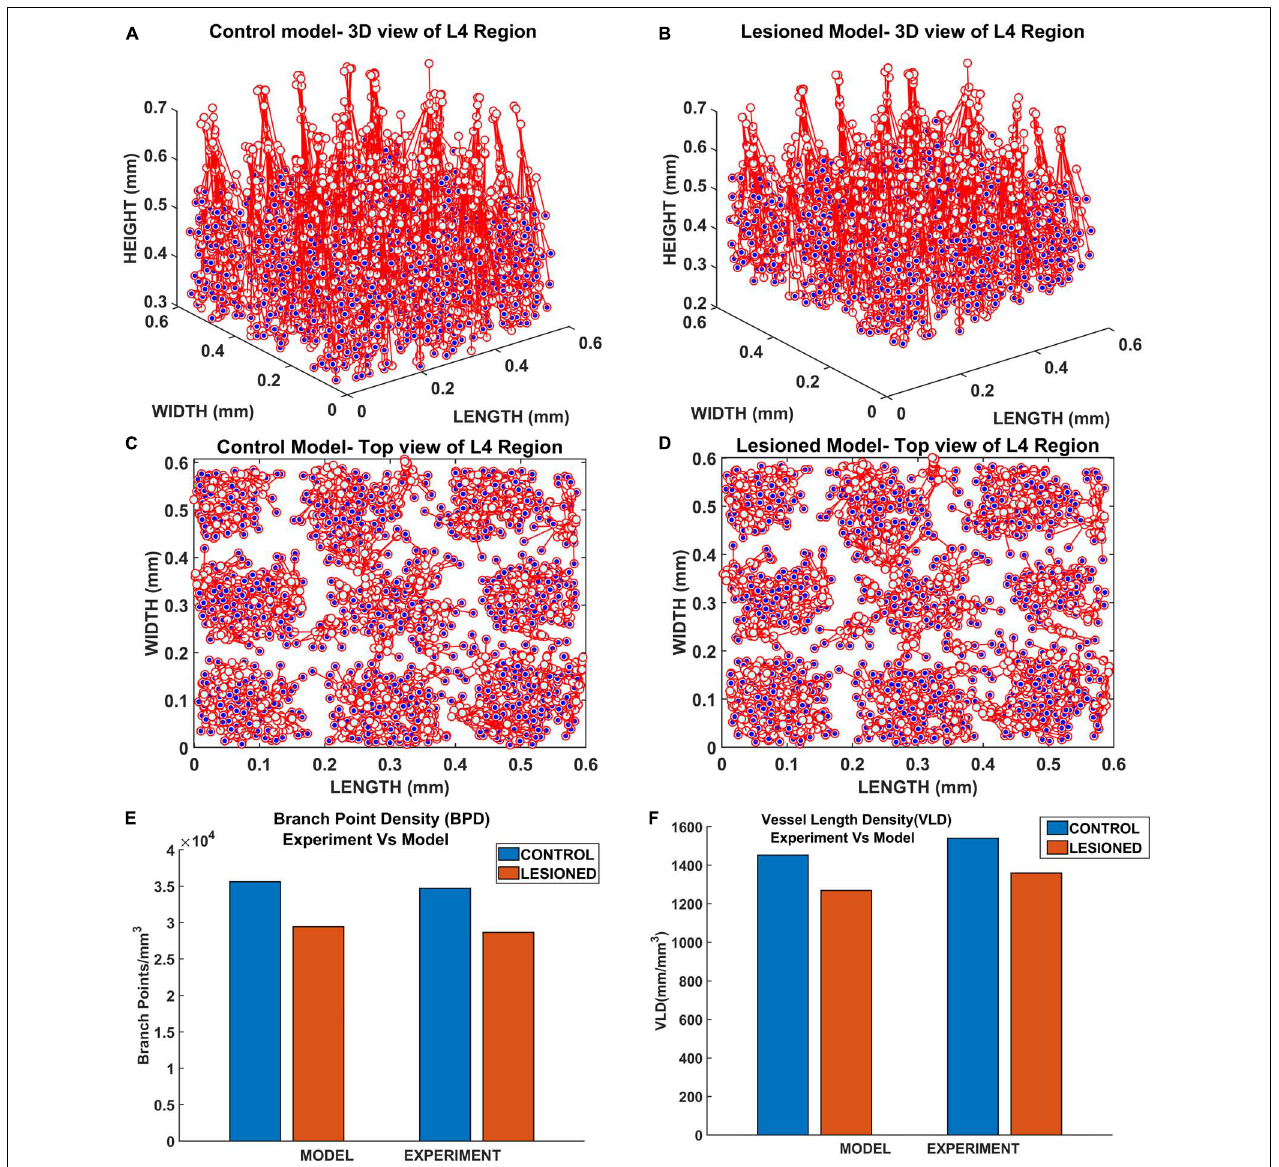
FIGURE 14 | The vascular arborization in L4 region of whisker barrel in (A) control model and (B) lesioned model; Top view of the vascular arborization in L4 region in (C) control model, (D) lesioned model, and (E) comparison of branch point density (BPD) in control and lesioned animal. (F) Comparison of vessel volume length density (VLD) in control and lesioned